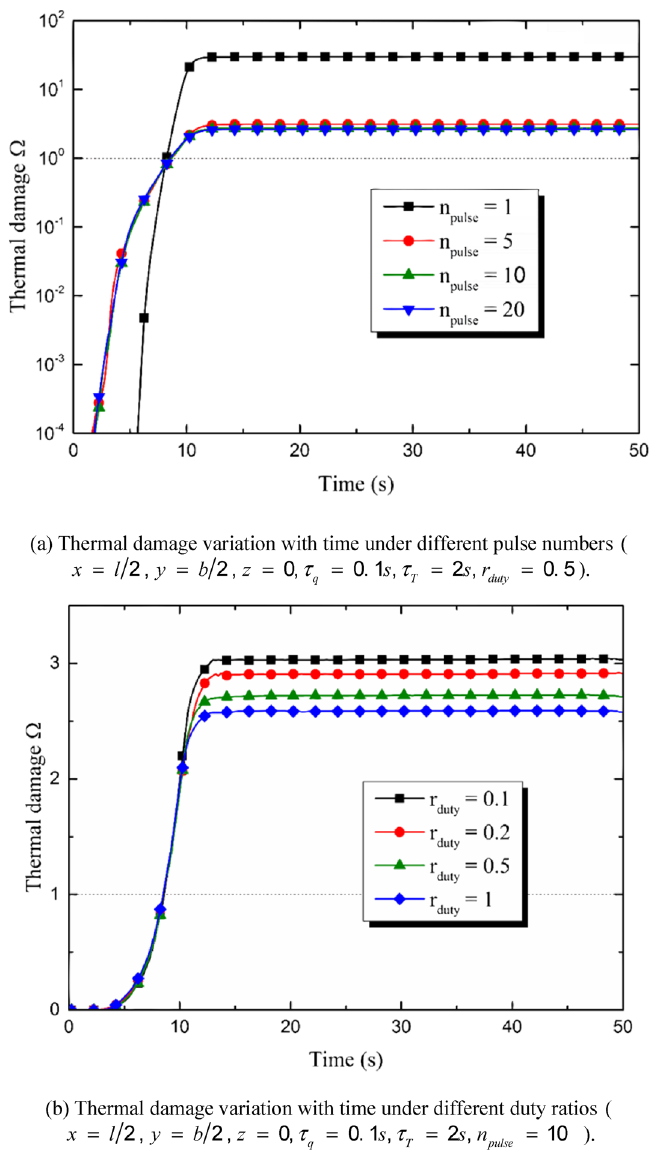
Figure 9. Influences of the heat source parameters on the thermal damage induced by the multi-pulse